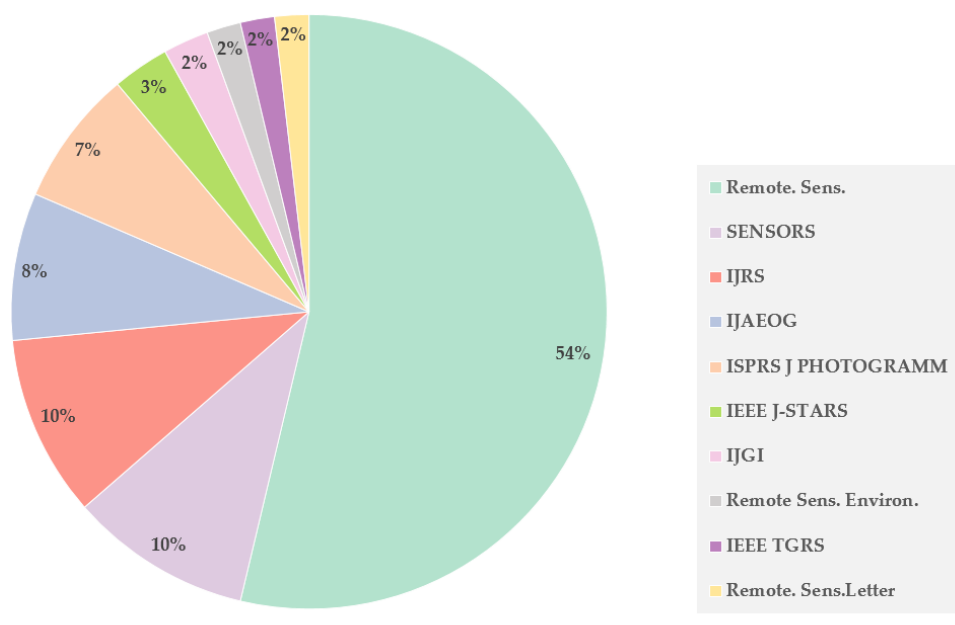
Figure 5. The number of relevant published articles per journal. Journals with more than three